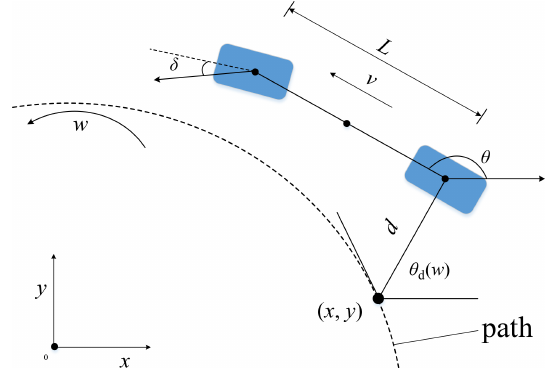
Figure 4. Kinematic model with